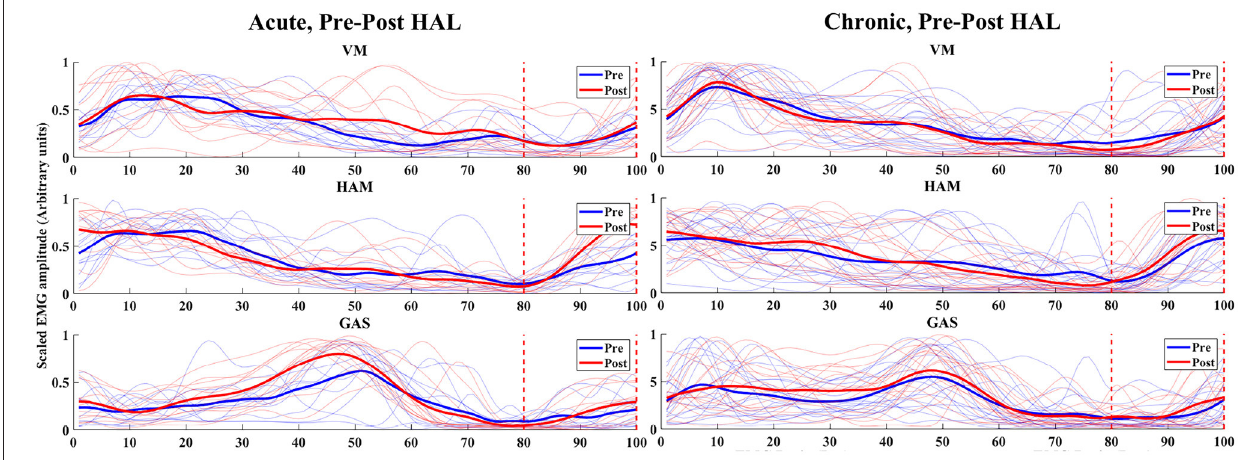
FIGURE 4 | EMG (VM, HAM, and GAS) of acute and chronic stage patients, pre and post HAL intervention – The normalized time correspond to the percentage of walking cycle. The blue and red lines shows pre and post HAL intervention plots of each subject’s EMG, respectively. The solid blue and red lines are mean plots of all subject’s pre and post HAL intervention in the group, respectively. Eighty percent to one hundred percent of gait cycle and the late swing phase to terminal swing phase was estimated using synchronized motion data.